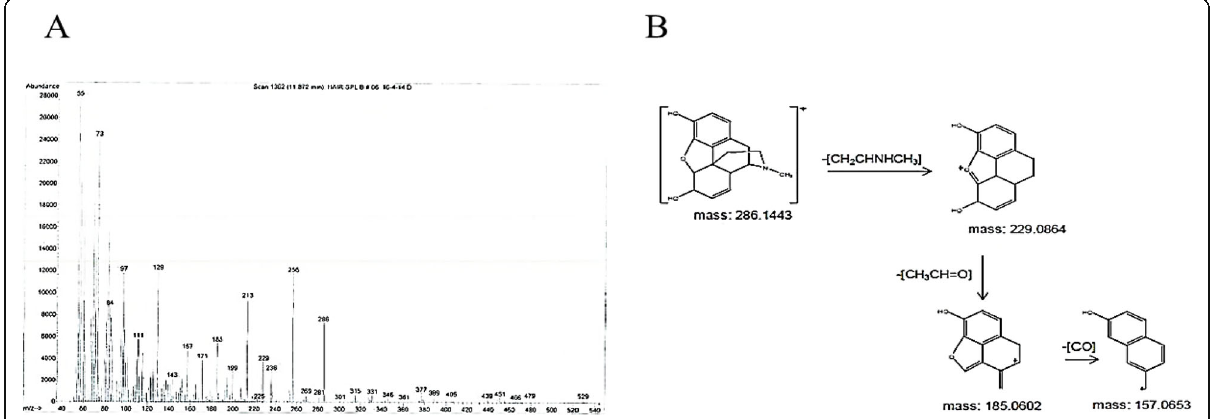
Fig. 2 Analysis of the sample taken from the de-addiction center group. a Mass spectrum of the sample from the de-addiction center group. b Fragmentation pathway observed in the sample from the de-addiction center group. The key ions detected in this spectrum were of 6- acetylemorphine and morphine forming a peak at ( m / z ) 331 and 286,